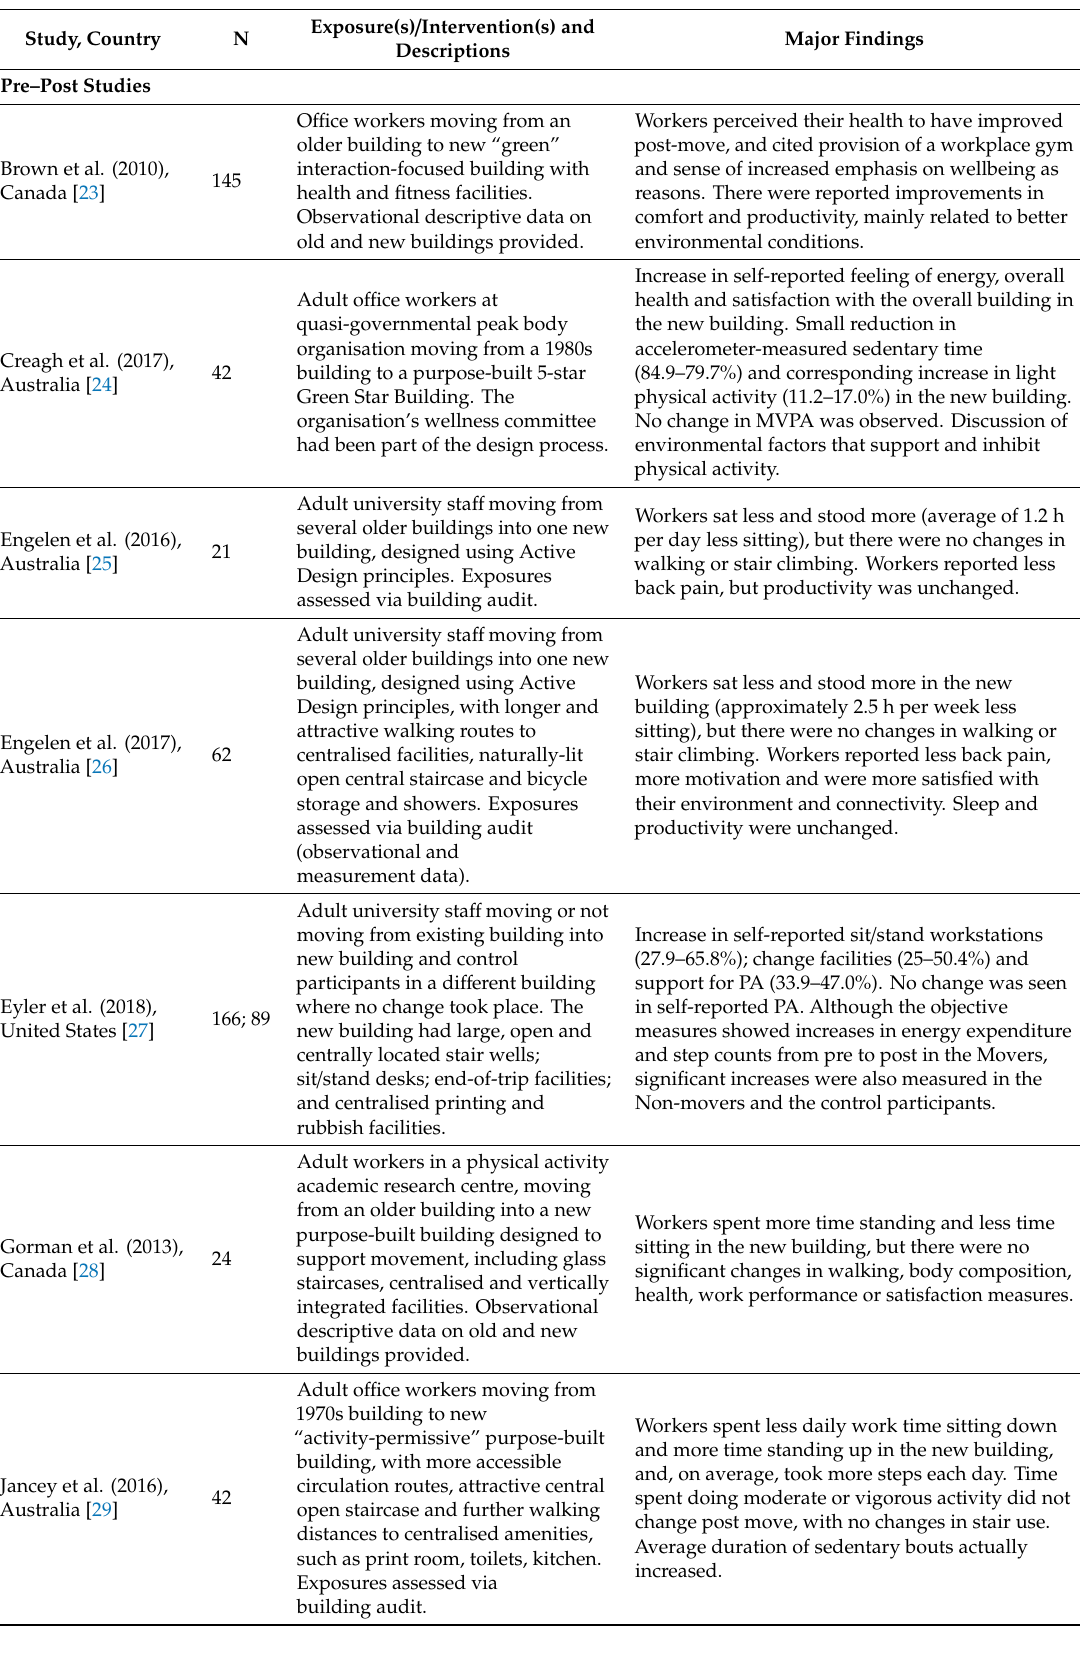
Table 1. Summary information of data extraction divided by type of study